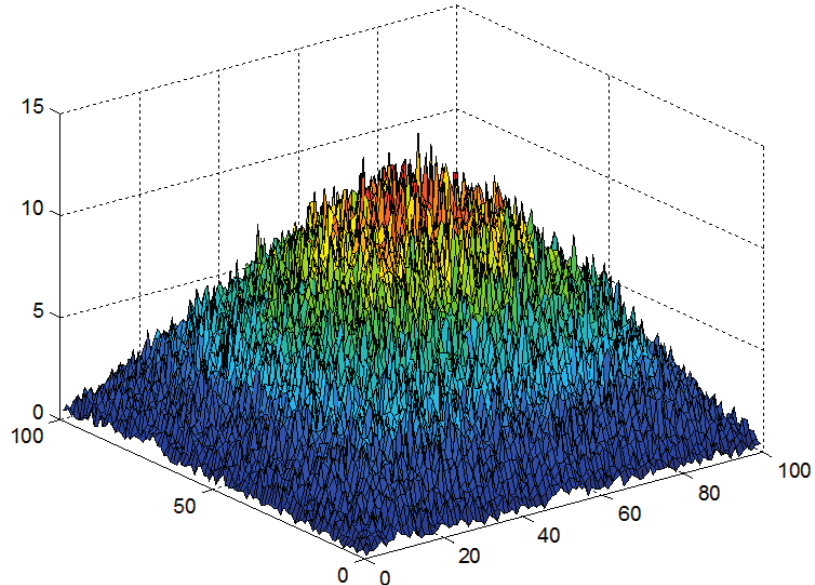
Figure 7. Node distribution under